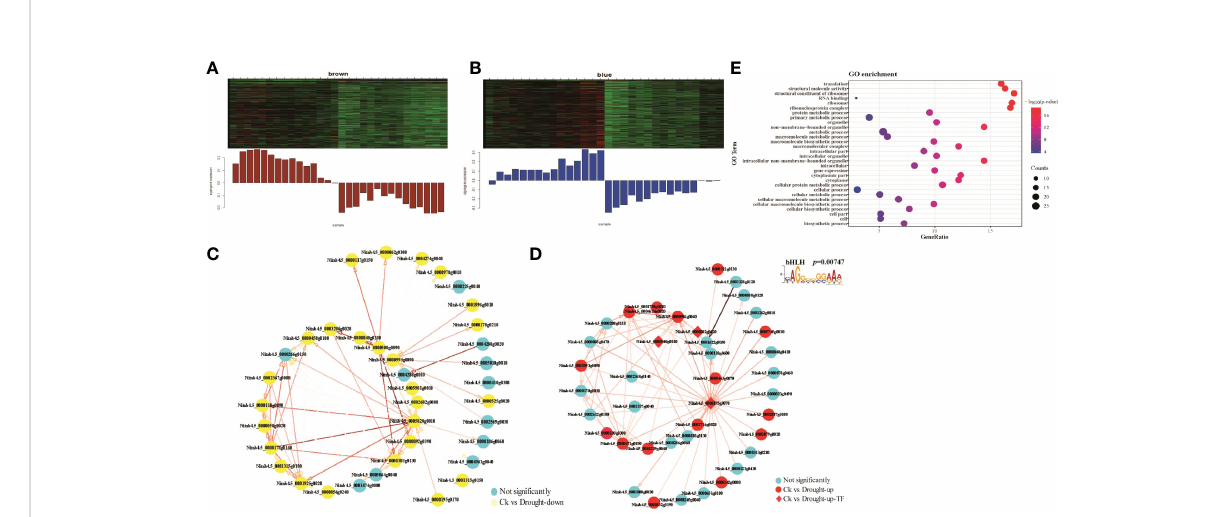
FIGURE 7 WGCNA analyses. (A) Module gene expression pattern in the brown module, red representing up-regulated genes, the green representing down-regulated genes. (B) The correlation network of genes in the brown module. A gene network is constructed by WGCNA, in which each node represents a gene, and the connecting line between genes represents the co-expression correlation, the blue representing not signi fi cant genes and the yellow representing down-regulated genes between M28 and K326 before and after drought treatment. The genes with weights >0.1 are visualized by Cytoscape. (C) The correlation network of genes in the blue module. (D) The correlation network of genes in the blue module. The red representing up-regulated genes and the blue representing not signi fi cant genes. The diamond representing the TF in the co- expression network. (E) GO term enrichment analyses of down-regulated genes in the brown module.